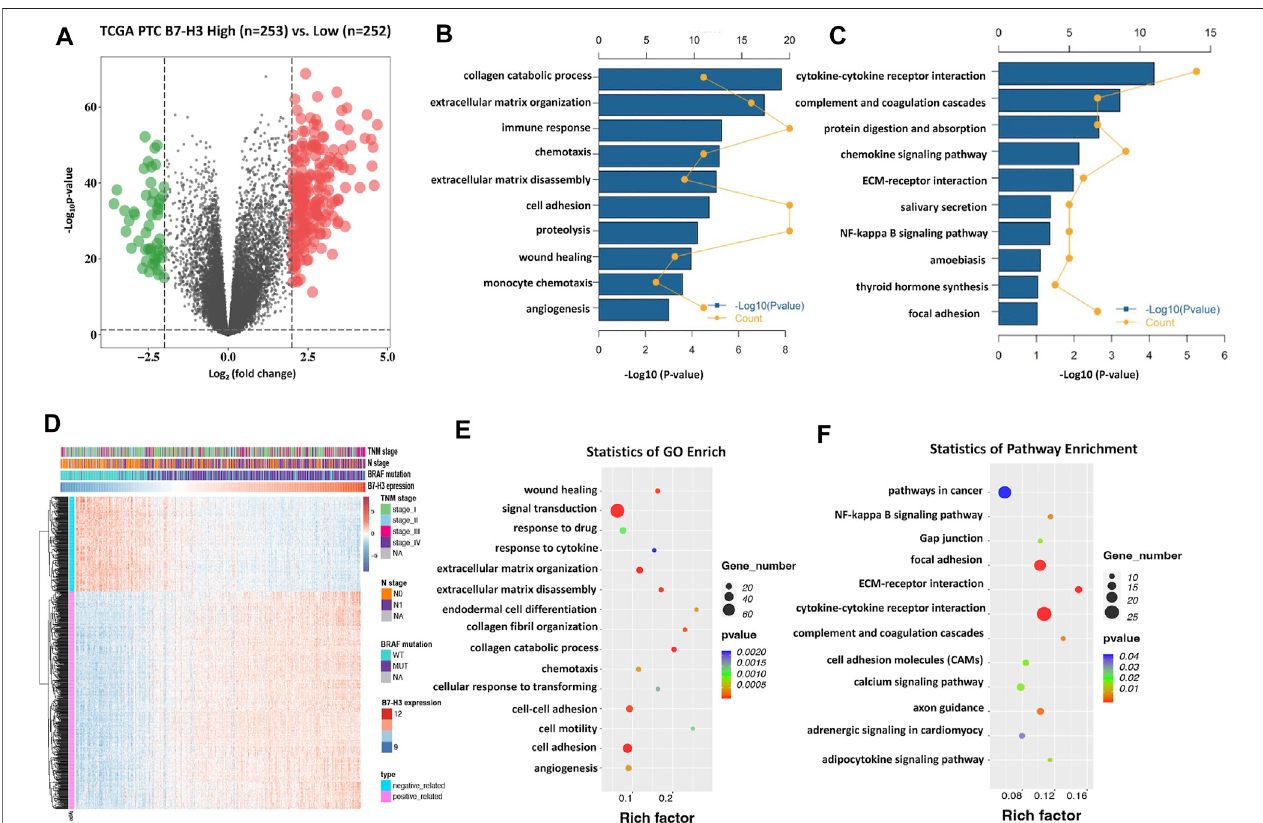
FIGURE3| B7-H3 – related biologicalprocessandpathways inPTC.Differentiallyexpressed genesinVolcanoplotsfromTCGAdataset (A) .Geneenrichmentwith GOterms ofselectedgenes (B) .GeneenrichmentwithKEGGtermsofselectedgenes (C) .Particularsofriskscoreandmost-related genesinheatmap (D) .Thebubble plots showing that B7-H3 is closely correlated with cell invasion, immune response and angiogenesis (E,F) .